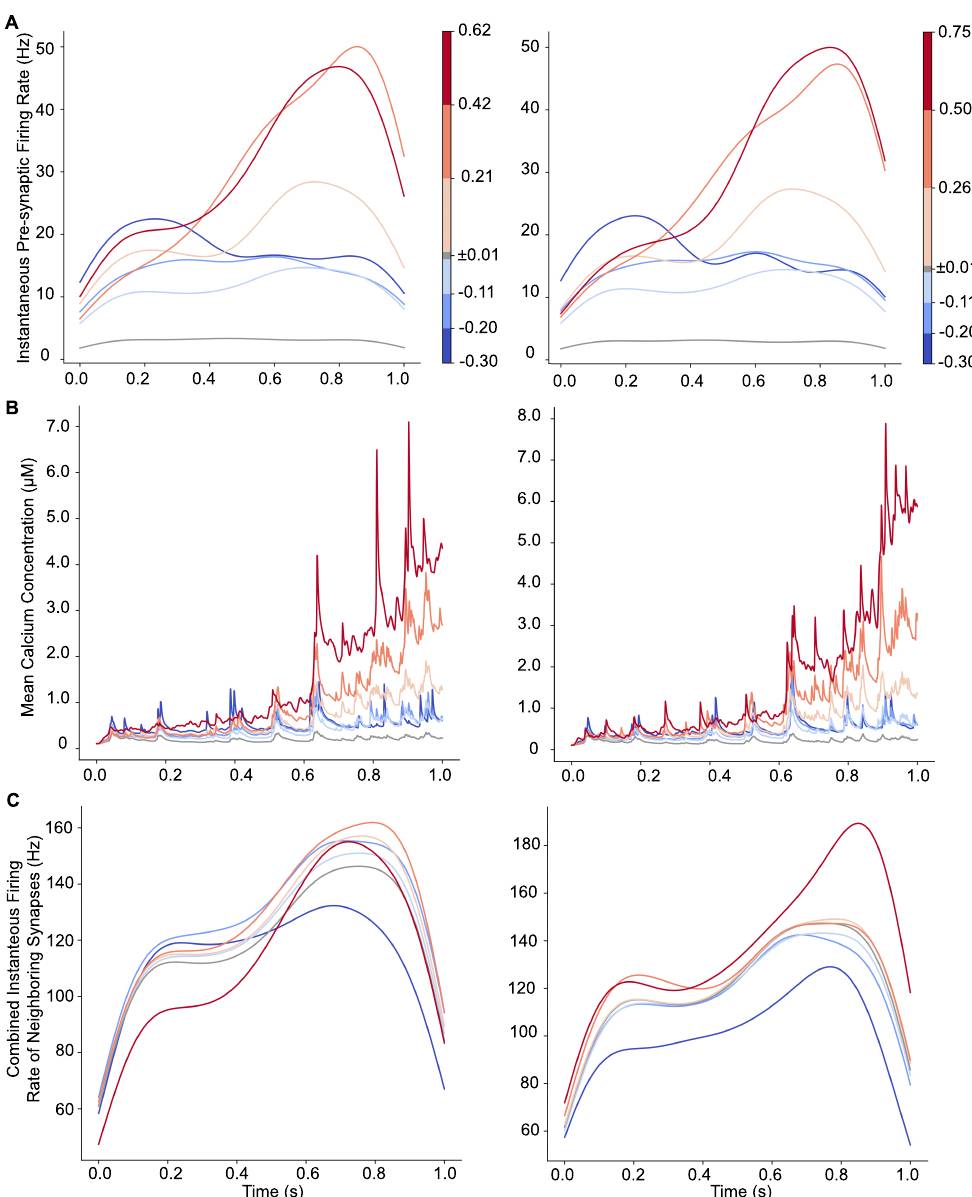
Figure 7. Temporal pattern of input predicts weight change for different variations of the mapping from spike trains to synapses. Weight change triggered average pre-synaptic firing rate and calcium concentration for two different sets of mappings from spike trains to synapses. ( A ) Weight change triggered pre-synaptic firing rate for two different sets of 24 different mappings. Synapses that potentiate have a transiently high firing rate at the end of the trial. ( B ) Calcium concentration for two different sets of 24 different mappings. Calcium concentration determines direction of plasticity as shown by the weight-change-triggered-average. Regardless of whether peak synaptic firing rate occurs early or late in the trial, calcium concentration is highest during the second half of the trials. ( C ) Weight change triggered pre-synaptic firing rate of 19 neighboring synapses. For synapses in each weight change bin, the spike trains for the 19 neighboring synapses are combined into a single train, and then instantaneous firing rate is calculated from that single